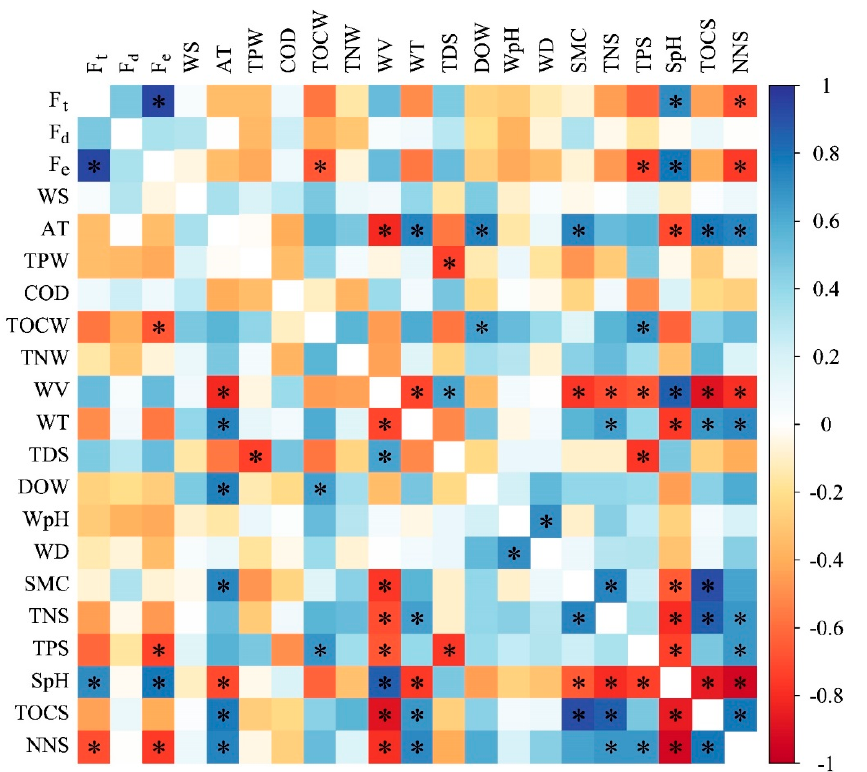
Figure 4. The correlations between CH 4 fluxes and physicochemical variables. Spearman’s rank correlation coefficients are presented in the boxes in different colors. Blue represents positive correlation, red indicates negative correlation, and white means no correlation. The asterisks (*) mean the correlations are statistically significant ( p < 0.05). (Abbreviation: F t , total CH 4 flux; F d , CH 4 diffusion flux; F e , CH 4 ebullition flux; WS, wind speed; AT, Air temperature; TPW, total phosphorus in water; COD, chemical oxygen demand; TOCW, total organic carbon in water; TNW, total nitrogen in water; WV, water velocity; WT, water temperature; TDS, total dissolved solid; DOW, dissolved oxygen in water; WpH, water pH; WD, water depth; SMC, sediment moisture content; TNS, total nitrogen in sediment; TPS, total phosphorus in sediment; SpH, sediment pH; TOCS, total organic carbon in sediment; NNS, nitrate nitrogen in sediment).